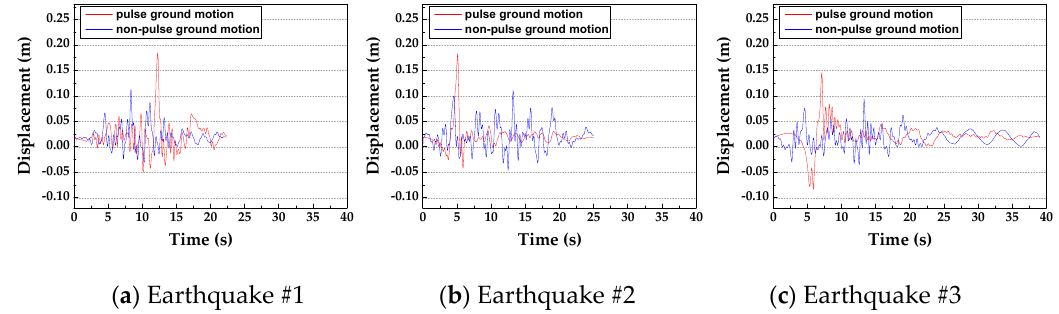
Figure 9. The horizontal displacement of point A with respect to point B (under the input angle of 75°).